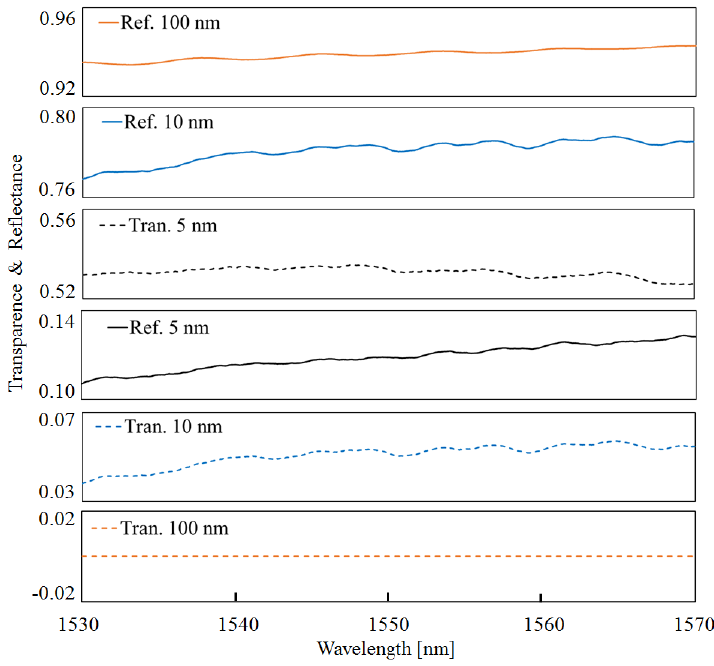
Figure 5. Spectra of the transmittance and reflectance of the gold thin films with various thicknesses.